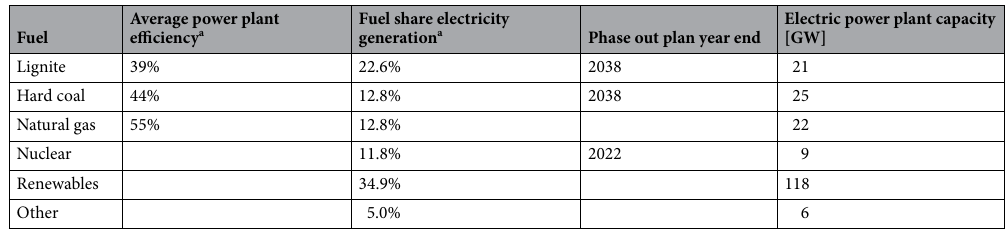
Table 1. German power plant fleet; a reference year 2018; (data sources: AGEB6,Wachsmuth et al. 10 ).